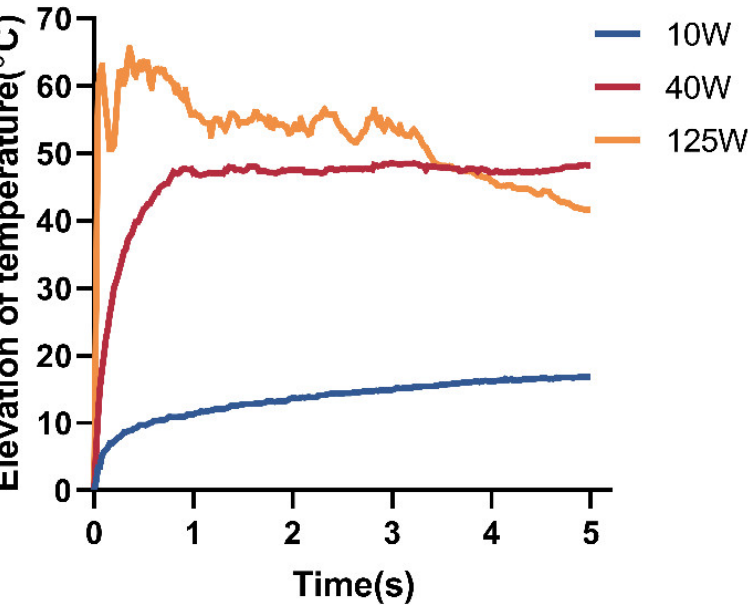
Figure 4. The measured temperature rise of the bovine liver tissue was exposed continuously for 5 s at 10 W, 40 W, and 125 W.